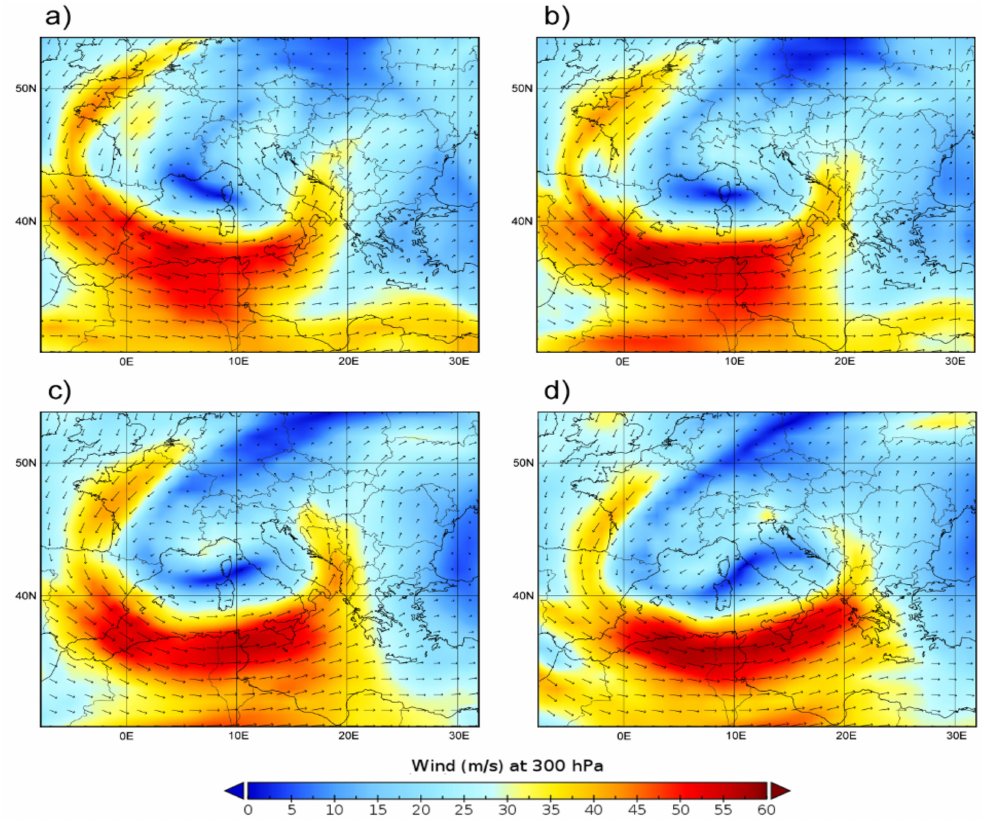
Figure 1. Wind speed intensity (colors, in m s − 1 ) and direction (vectors) at 300 hPa (about 9000 m) at ( a ) 00:00 UTC; ( b ) 06:00 UTC; ( c ) 12:00 UTC; ( d ) 18:00 UTC, on 23 November